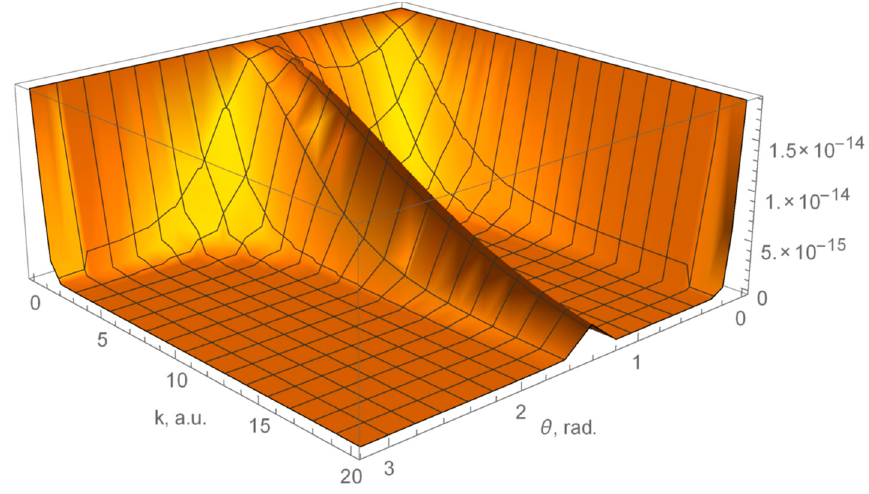
(cid:104) (cid:105) cm 2 d 2 , θ is a scattering angle and k a wave vector module d Ω Strad fi , θ is a scattering angle and k a wave vec-